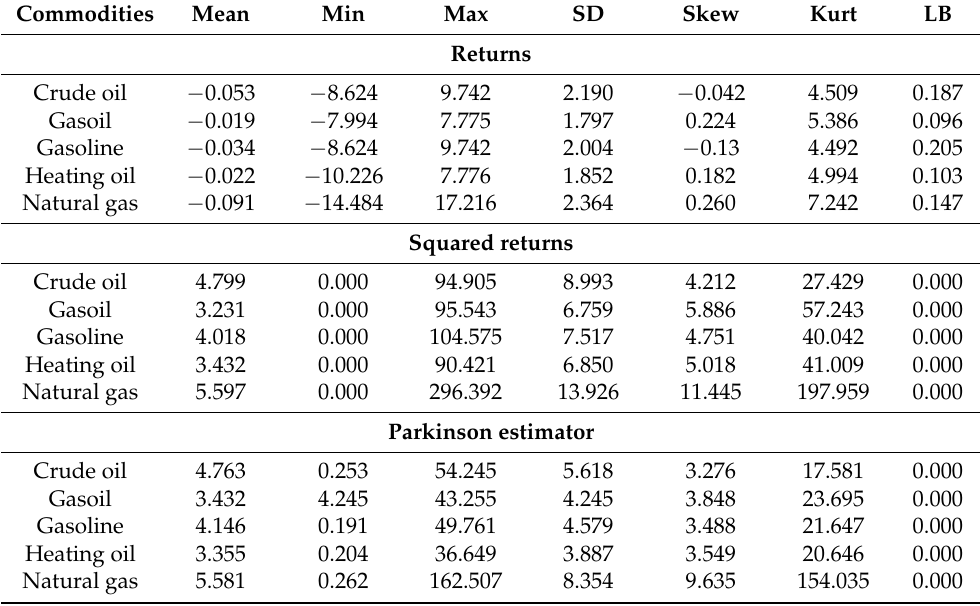
Table 1. Summary statistics of daily returns, squared returns and values of the Parkinson estimator.